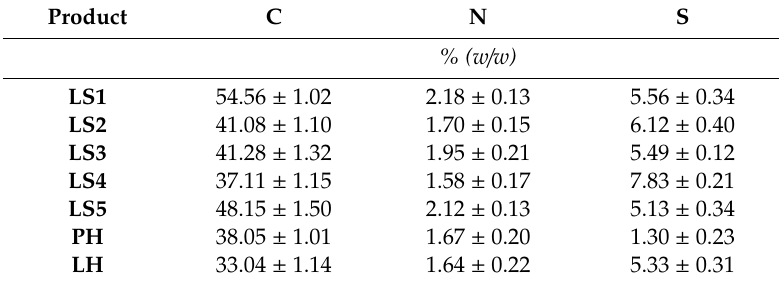
Table 1. Elemental analysis of carbon (C), nitrogen (N), and sulfur (S) in the di ff erent